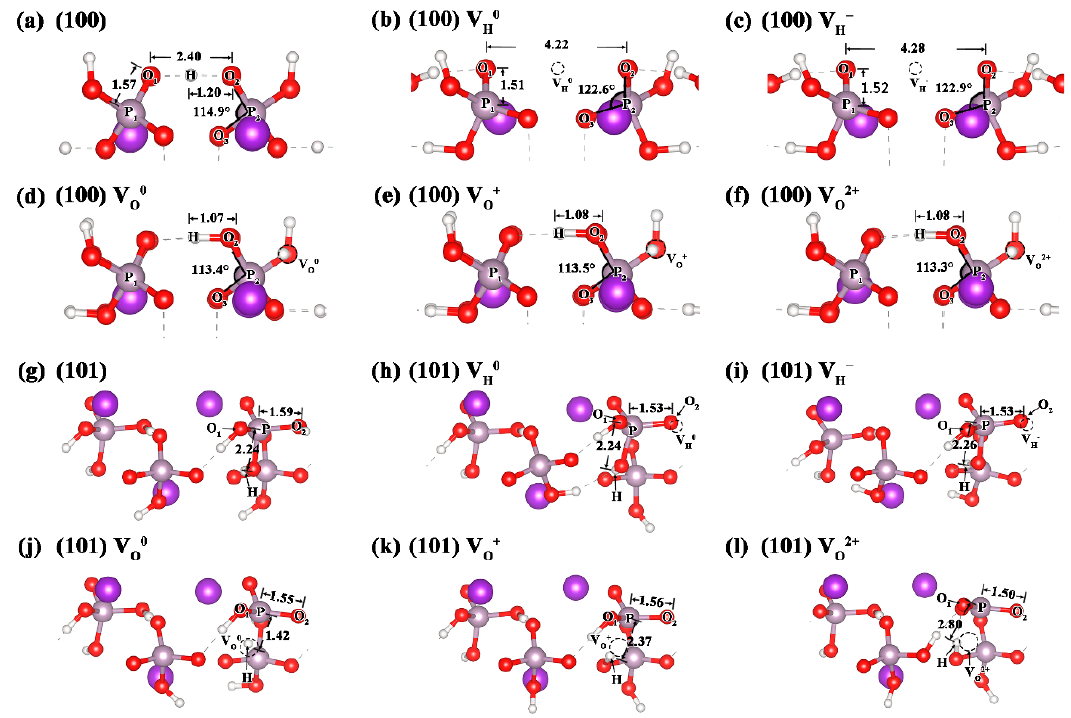
Figure 2. ( a ) Structure of the (100) surface of KDP crystals, local lattice distortions of neutral and charged V H ( b , c ) and V O ( d – f ) defects on the (100) surface of KDP crystals, ( g ) structure of the (101) surface, and local lattice distortions of neutral and charged V H ( h , i ) and V O ( j – l ) defects on the (101) surface of KDP crystals. The dotted circles mark the position of the vacancy defects.